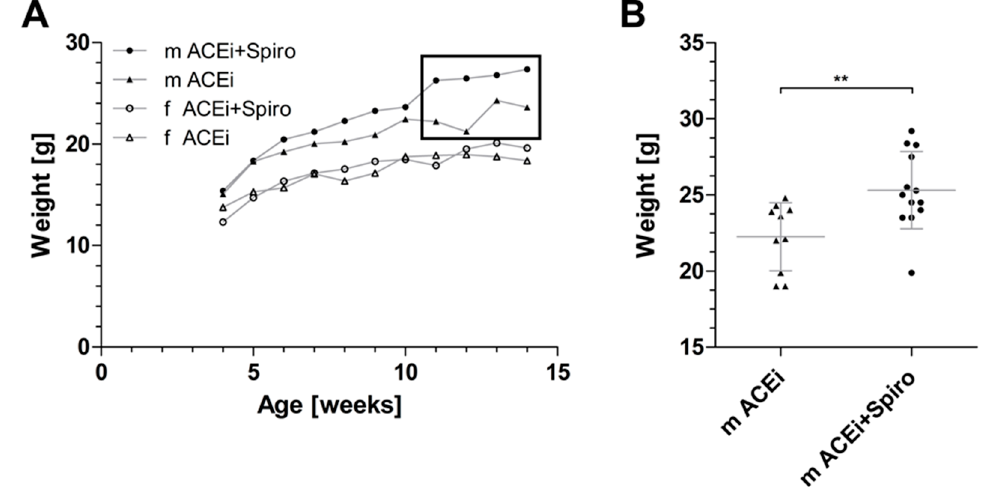
Figure 6. Anti-androgen side-effects of spironolactone on body weight. ( A ) Mean body weight of male and female Alport mice in the ACEi group vs. dual treated mice (ACEi+Spiro); ( B ) Individual measures of body weight of fully grown adult male mice in the ACEi group vs. dual treated males (ACEi+Spiro) as shown in the box in graph A ( n = 10–13 datapoints for each group). m = male; f = female; ** p < 0.01.